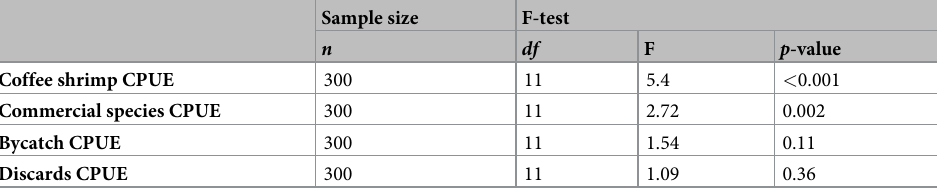
Table 1. Results from Generalised Least Squares model to assess overall effects of time on